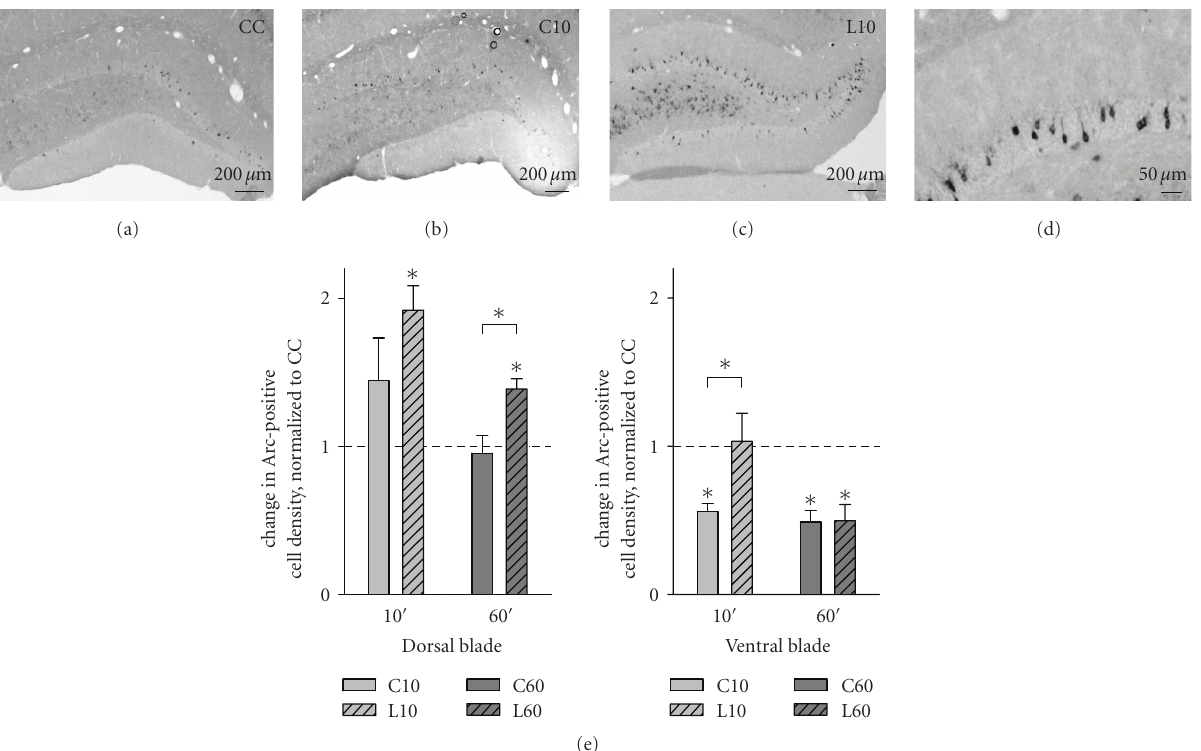
Figure 3: Object recognition training increases Arc mRNA expression in the dentate gyrus. Arc mRNA in situ hybridization reveals sparse expression of Arc in both dorsal and ventral blades of the rat dentate gyrus of (a) CC, (b) C10, and (c) L10 animals. (d) Higher magnification shows typical Arc mRNA localization in the cell body and dendrites of granule cells. (e) Change in Arc-positive granule cell densities (relative to the CC group) in the dorsal and the ventral blade of the dentate gyrus across the C10, L10, C60, and L60 groups. Data are presented as mean ± SEM ( n = 4 for all groups). Asterisks indicate P ≤ . 05 (if not indicated otherwise, relative to CC group). Scale bars represent 200 μ m in (a)–(c) and 50 μ m in